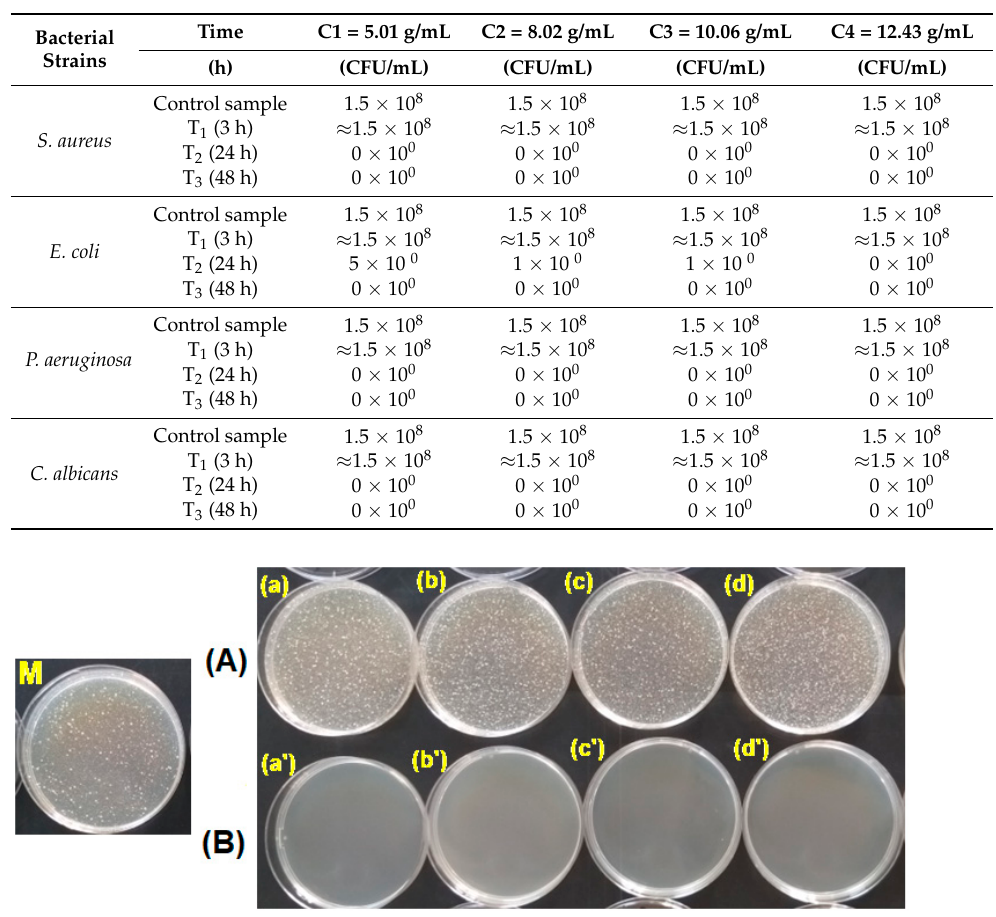
Table 4. Antimicrobial activity of PSFEtP + for different concentrations (C 1 –C 4 ) against standardized microbial species.